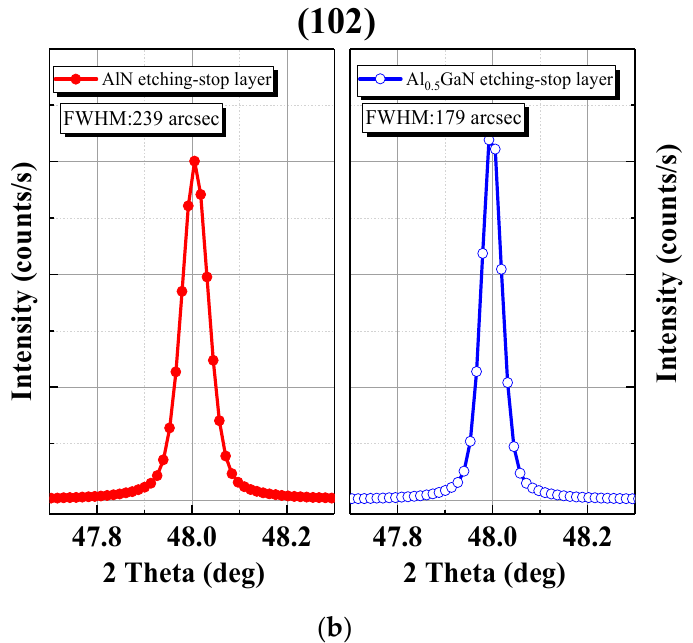
Figure 2. XRD measurement of the FWHM at the Al 0.5 Ga N etch-stop layer and AlN etch-stop layer. ( a ) (002) symmetric reflection and ( b ) (102) asymmetric reflection.